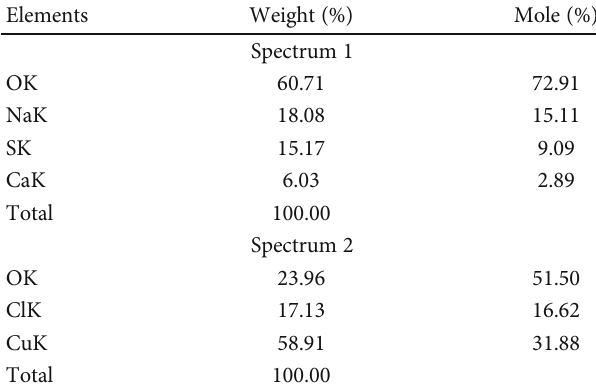
Table 2: The concentration of elements on grains in SEM of Figure